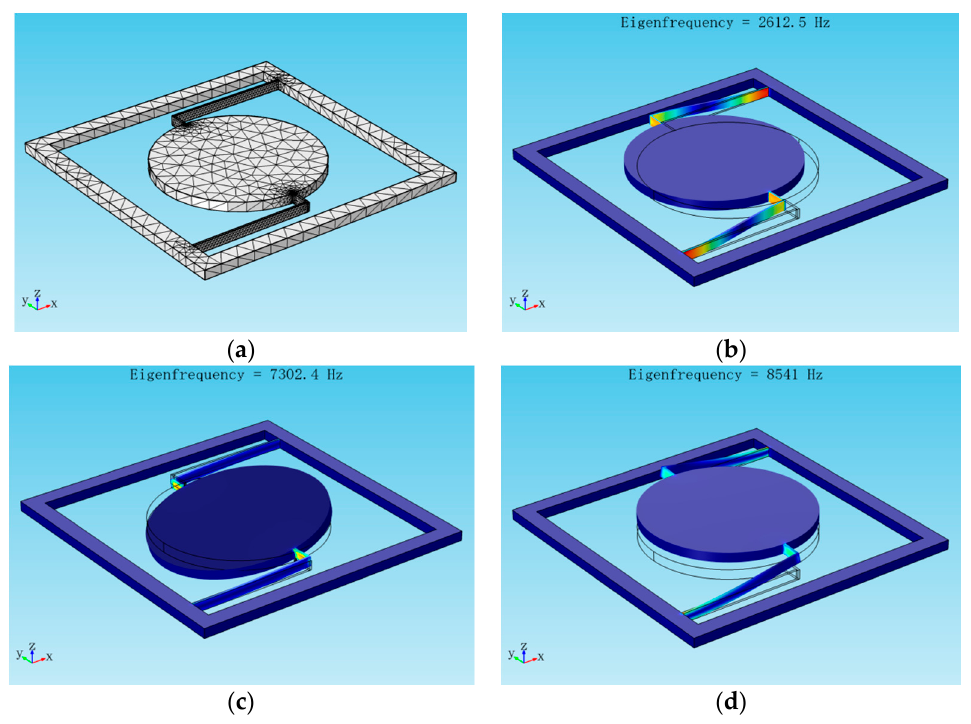
Figure 6. Model simulation of proposed accelerometer via FEM. ( a ) Model structure; ( b ) The first mode; ( c ) The second mode; ( d ) The third mode.